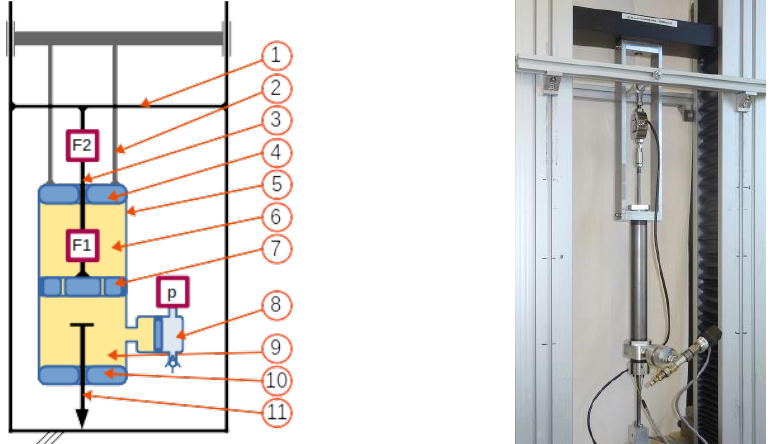
Figure 2. Principle ( left ) and actual setup ( right ) of the Single Friction Point Test Rig 1: rod guide assembly/rod and piston/tube. (1) frame; (2) actuation; (3) rod; (4) rod guide assembly; (5) tube; (6) upper oil volume; (7) piston; (8) pressure accumulator; (9) lower oil volume; (10) secondary rod guide assembly; (11) secondary